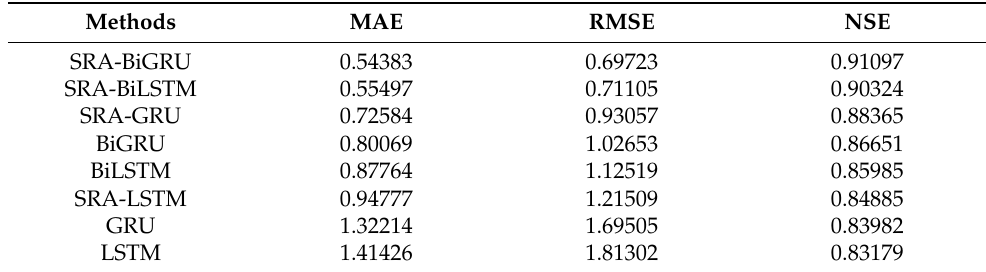
Figure 12. Evaluation index value of all models. Table 1. Evaluation index value of all